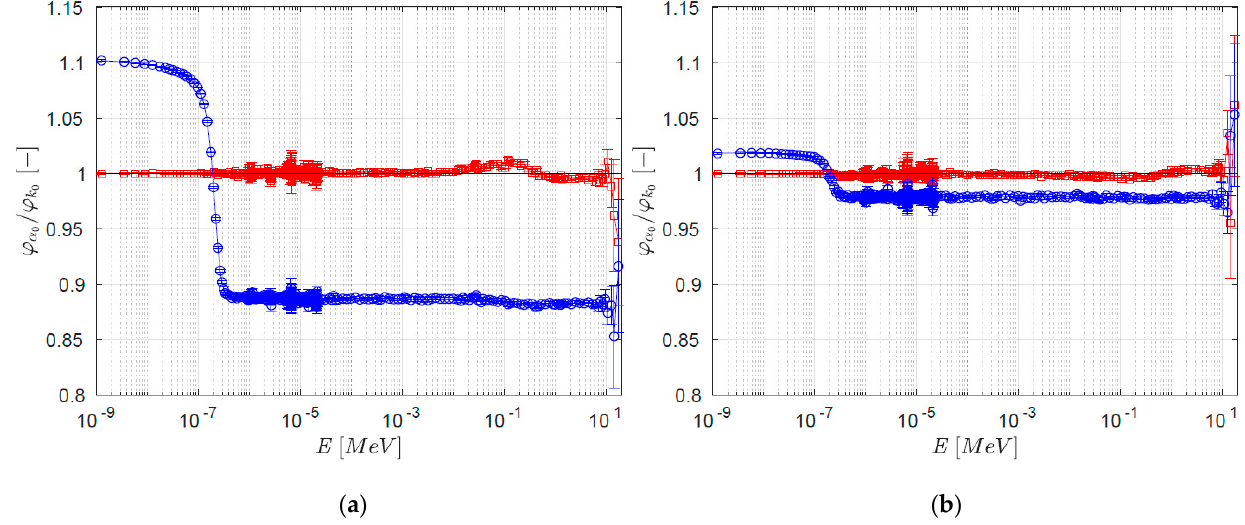
Figure 7. Problem III, ratios ϕ α / ϕ of the direct fundamental distributions, for sub-critical ( a ) and super-critical ( b ) configuration, with (red squares) and without (blue circles) delayed contributions.